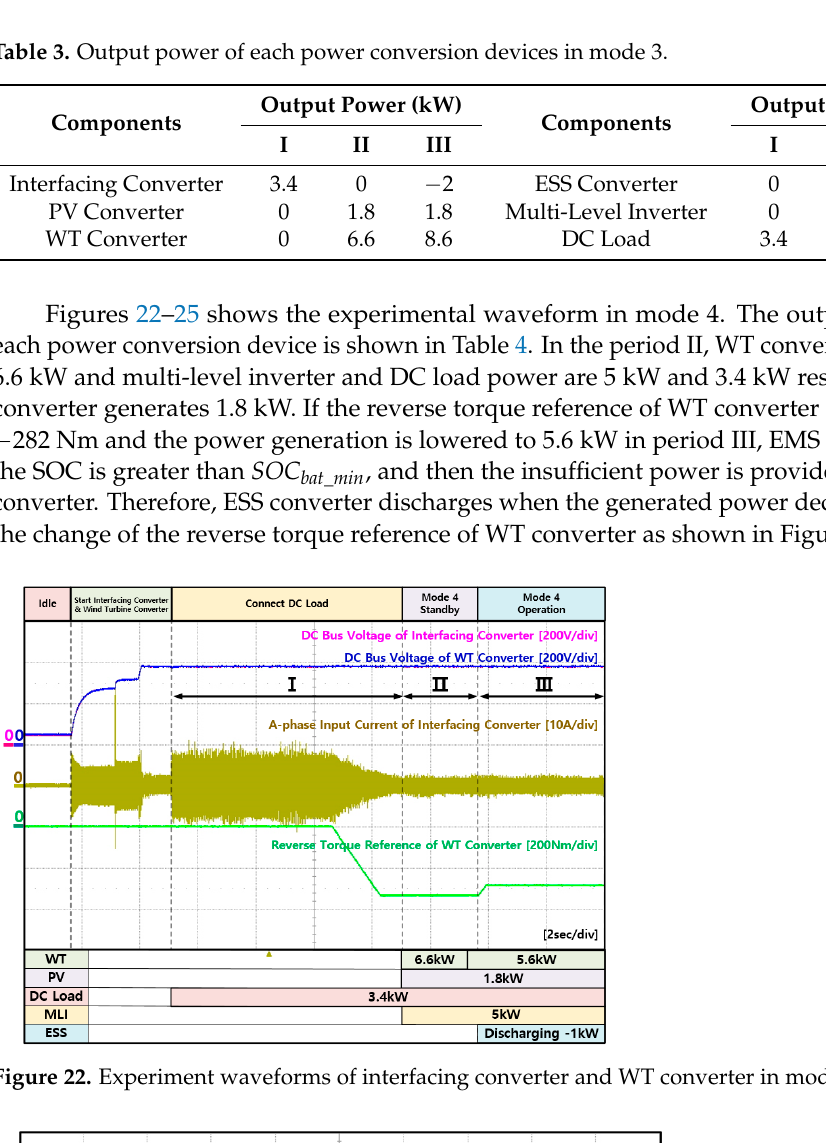
Table 3. Output power of each power conversion devices in mode 3. Figure 21. Experiment waveforms of PV converter and ESS converter in mode 3.